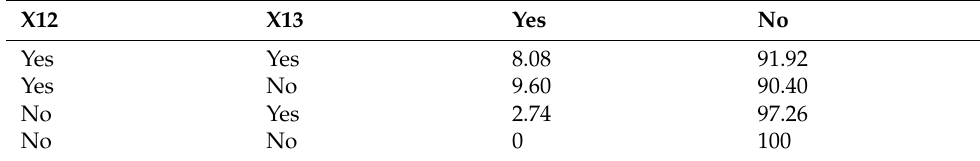
Table A8. Conditional probability of node M4.